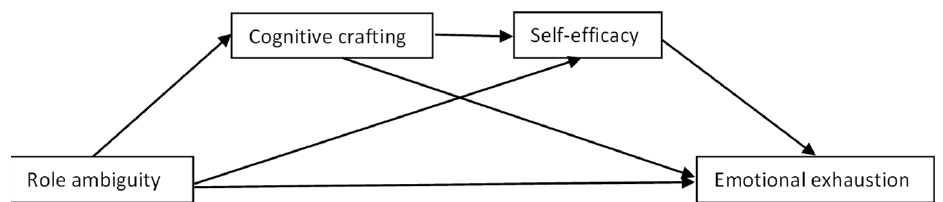
Figure 2. Hypothetical chain mediation model 2 (serial mediators: cognitive crafting and optimism).